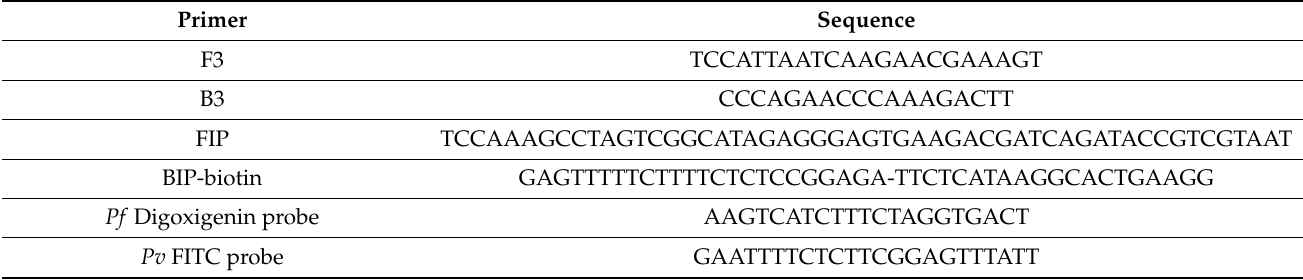
Table 1. The primer sequence for amplification of the Plasmodium genus and species using the loop-mediated isothermal amplification (LAMP) reaction is as shown